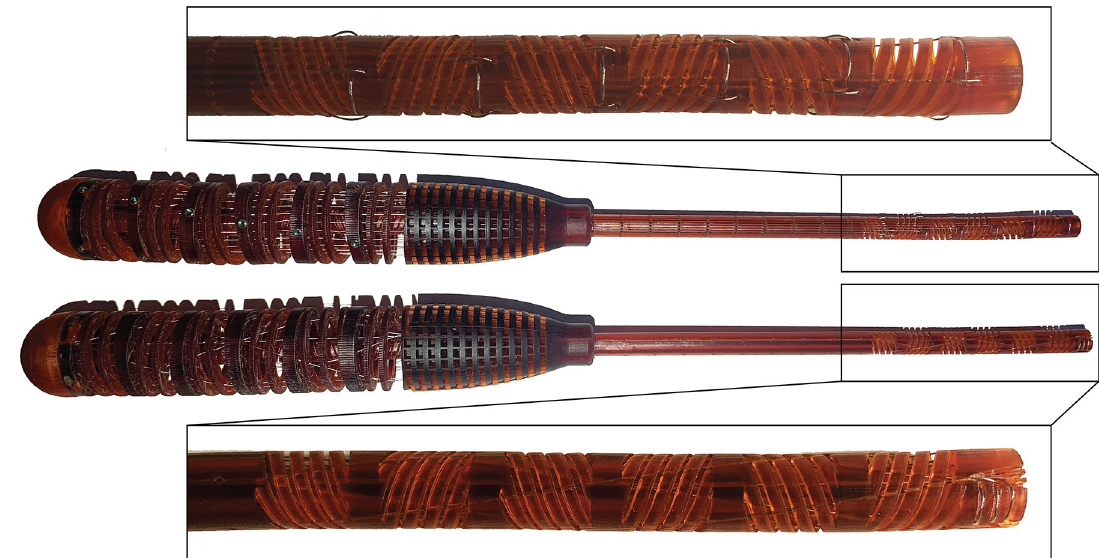
Fig 6. Instrument prototypes employing the parallel configuration (top) and multi configuration (bottom). The close-ups show the steerable shafts. Notice that the fixation points in the shafts differ, depending on the configuration. In the parallel configuration, each segment has two fixation points whereas in the multi configuration all cables are fixed at the distal end of the